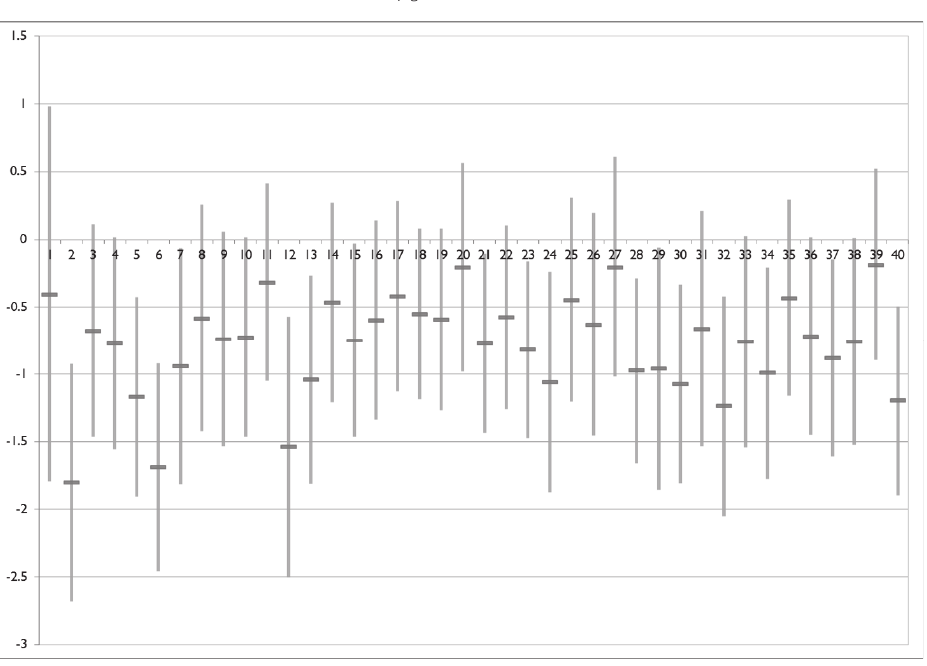
<Figure 6> Contextual peer effects ( µ gender ) for newly joined members (week 1 -